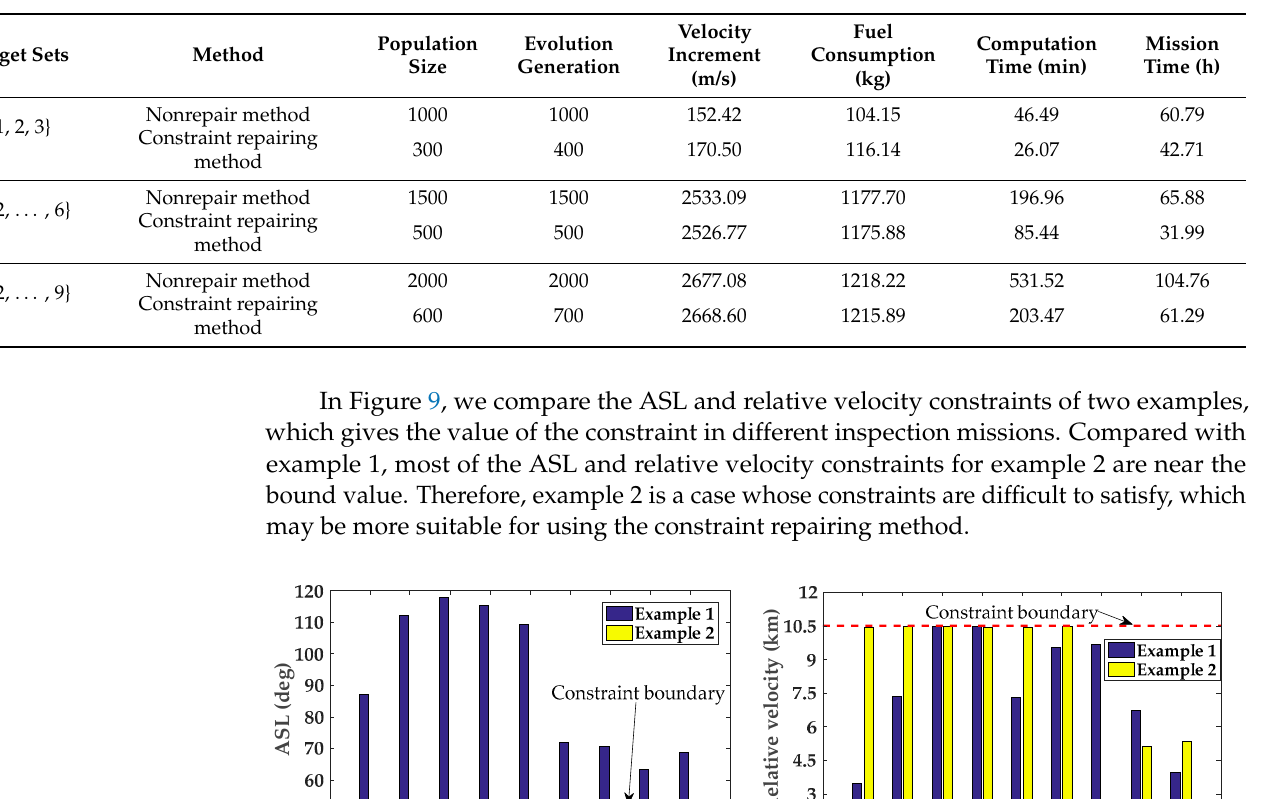
Table 8. Population size, evolutionary generation, velocity increment, fuel consumption, computation time, and mission time for different numbers of targets and different methods.